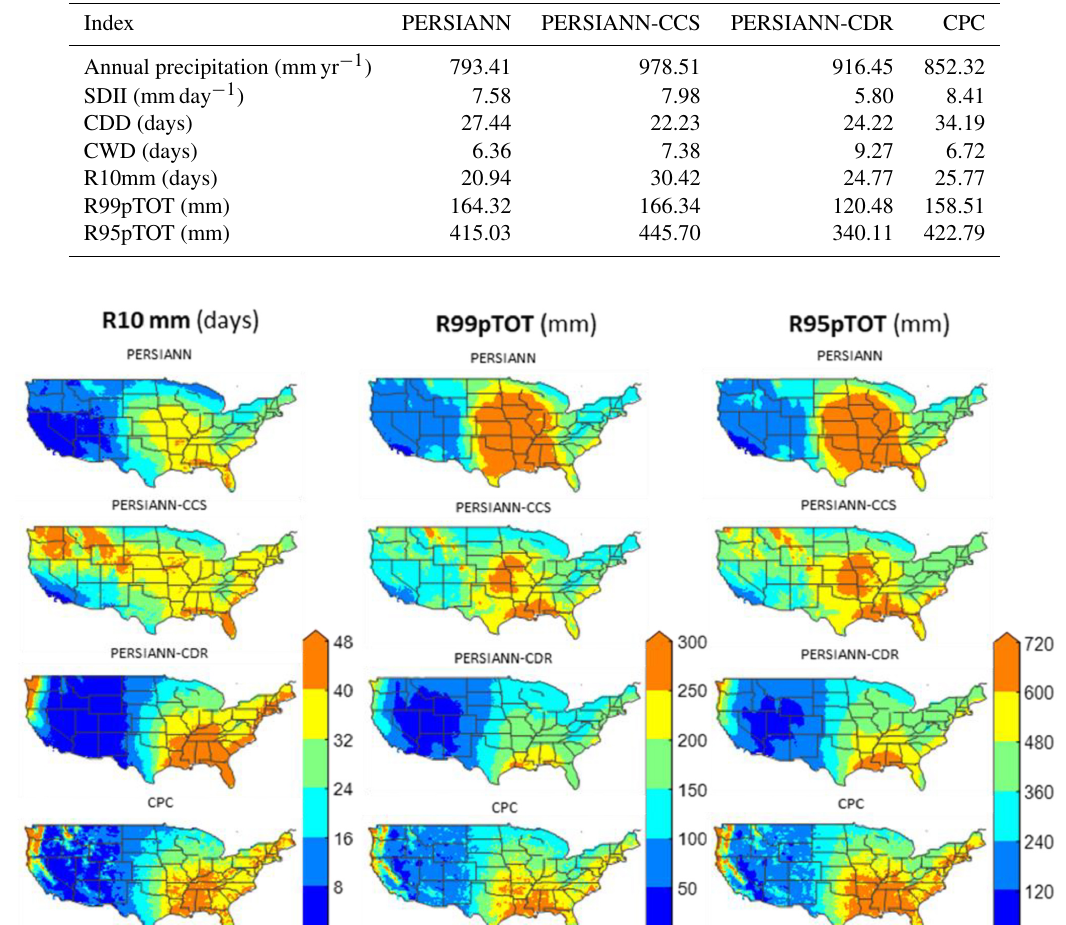
Table 5. Statistics of the PERSIANN family of products for the period (2003 to 2015) over the CONUS.